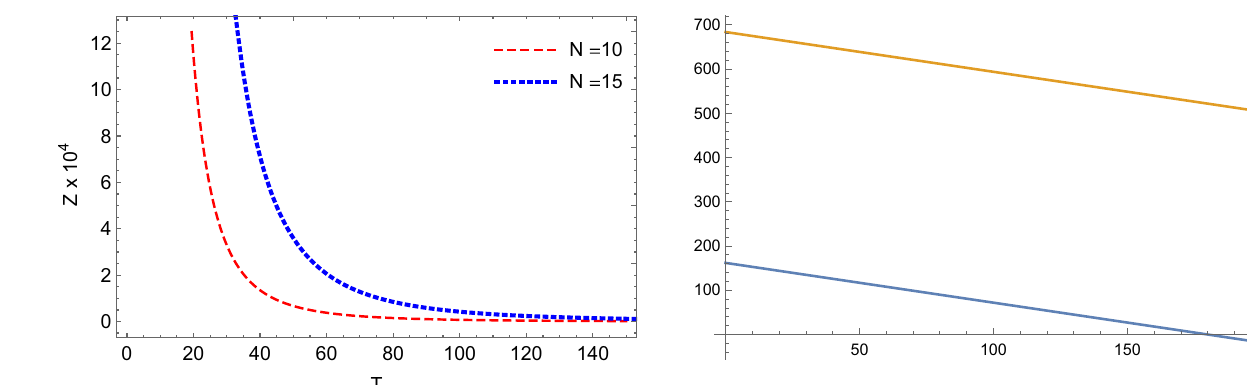
Fig. 9 Mean energy in terms of temperature with G = m = k = 1, and λ = 1 / 6. The blue line corresponds to N = 10 and the brown one to N =